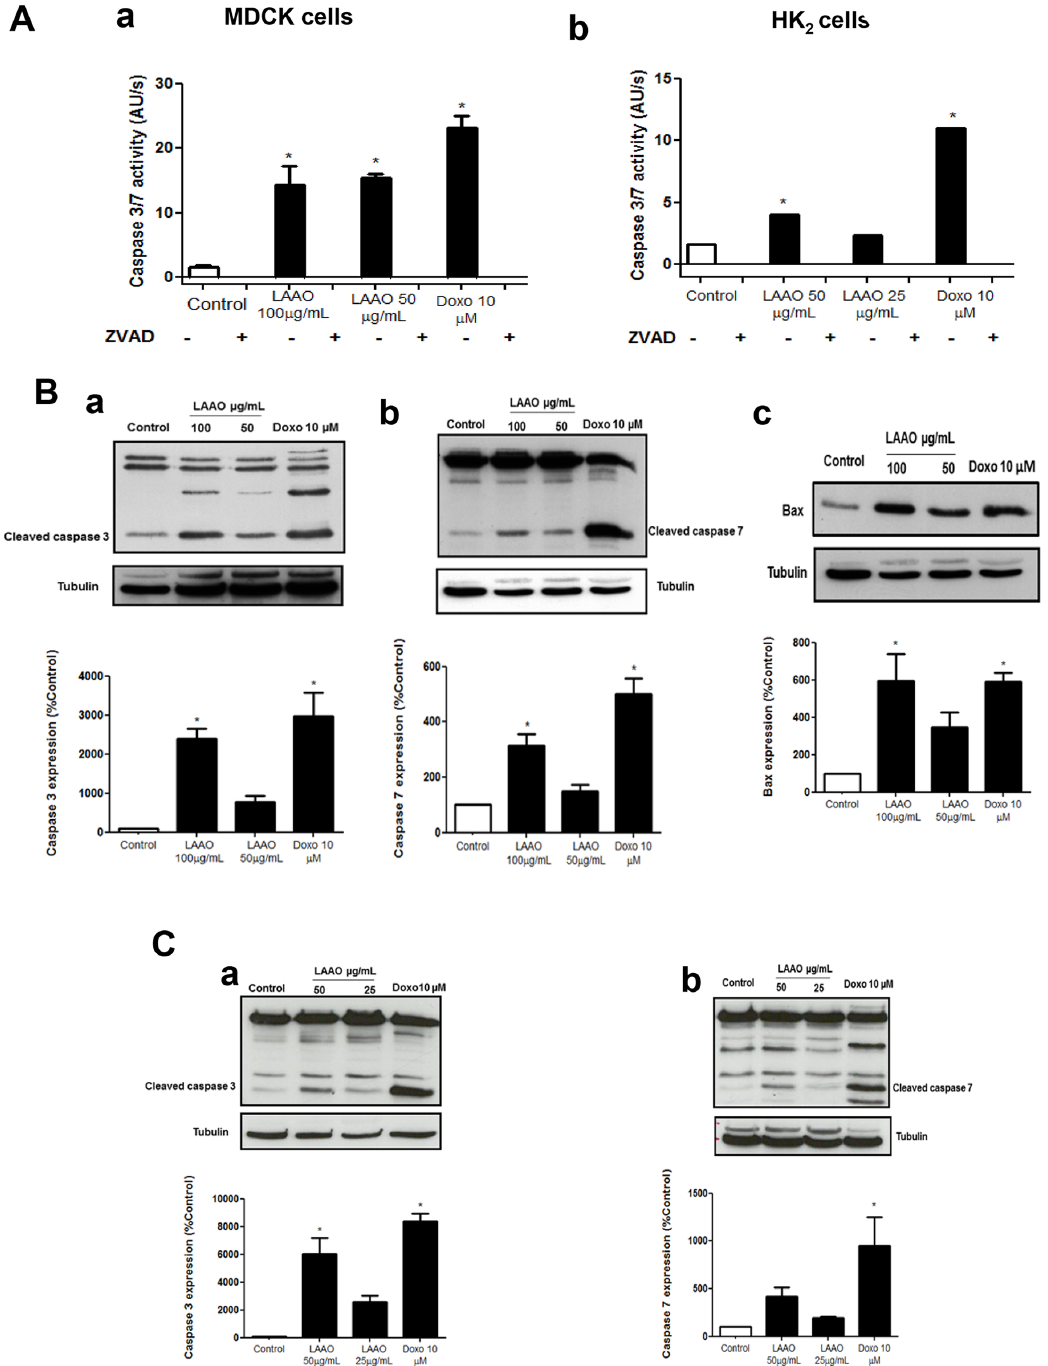
Fig 3. LAAO- Bl activates Bax, caspases 3 and 7 in epithelial kidney cells. (A) Caspase-3/7 activity was determined in the presence of the fluorogenic Ac- DEVD-afc substrate after treatment with LAAO- Bl (12 h) in the presence or absence of zVAD (10 μ M) in MDCK (a) and HK-2 cells (b). (B-C) Western blot analyses were performed to detect the effects of LAAO- Bl on changes in Caspase-3 (a), -7 (b) and Bax (c) expressions from total protein of MDCK (B) and Caspase-3 (a), -7 (b) HK-2 (C) cell extracts. Percentage of Caspase-3 (a), -7 (b) and Bax (c) expression in MDCK (B) and caspase-3 (a) and caspase-7 (b) HK2 (C) treated with LAAO- Bl for 12 h. Data normalized in relation to Control group. Protein bands were analyzed and normalized to the densitometric values of α -tubulin. Doxorubicin was used as positive control (10 μ M). Data are representative results of three independent experiments.